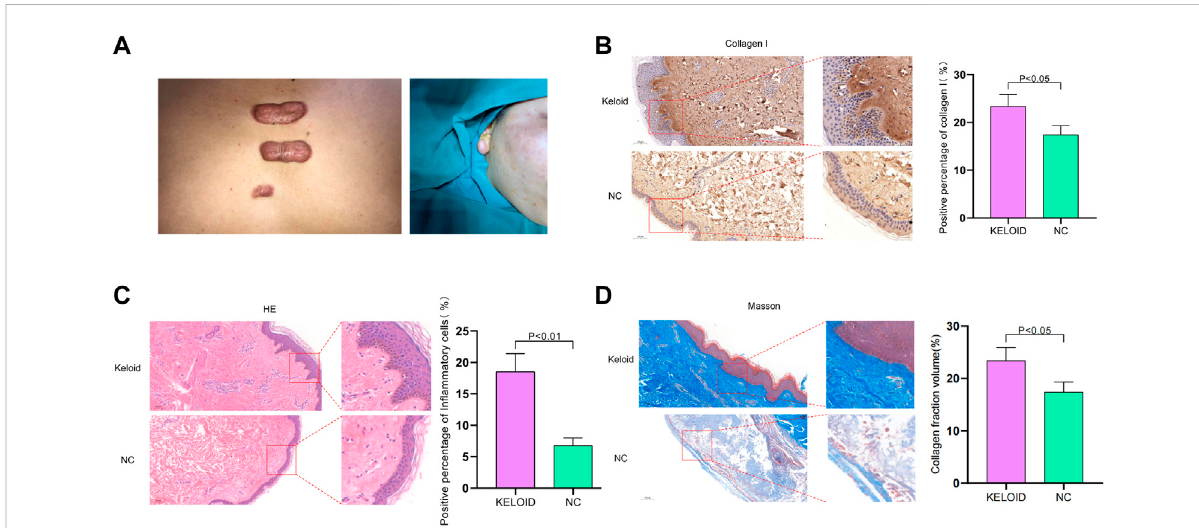
FIGURE 2 (A) Illustrationofkeloid.Thekeloidlesionexceedstheextentoftheoriginalskindamageandhasaraised,toughsurfacewithareddishcolor. (B) Accordingtohistologicalevaluation,thekeloidtissuewasbeyondtheoriginalwound ’ smargin,andhadaclaw-likeleadingedge,whichisaninvasive edge. The positive percentage of collagen I in keloid was clearly increased compared to normal skin tissue and the keloid tissue was clearly invading inwards. (C) The positive percentage of in fl ammatory cells in keloid was signi fi cantly higher than in normal skin tissue and the cells were dense and irregularly arranged compared to the normal skin tissue. (D) The collagen fraction volume was higher than in normal skin tissue. The